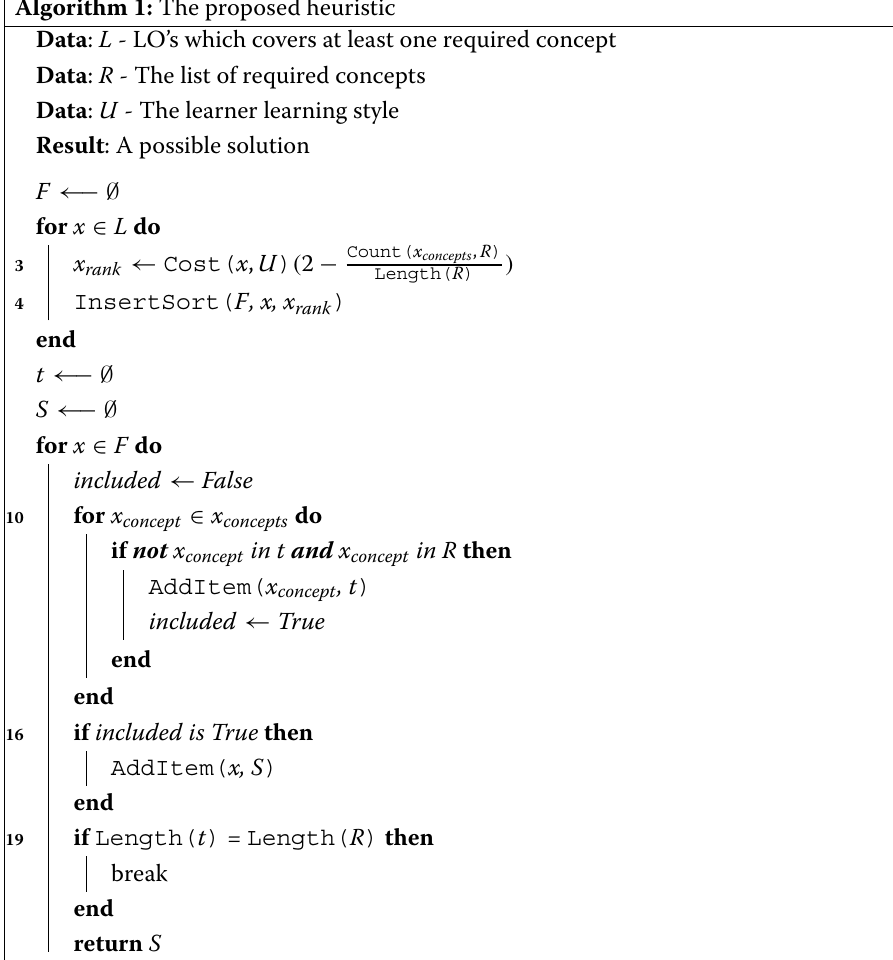
Algorithm 1: The proposed